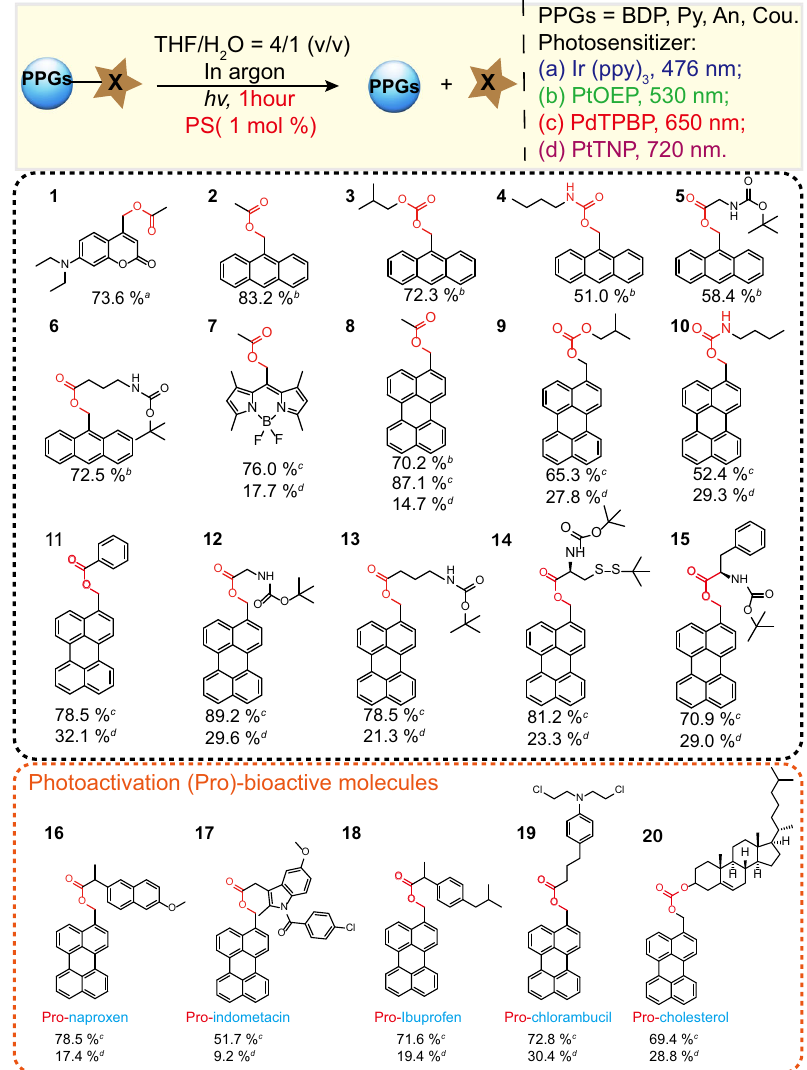
Fig. 2 Triplet – triplet annihilation-mediated photolytic reactions under diverse low power long wavelength LED irradiation. The superscripts (a – d) next to the reaction yields represent the sensitizers used and their respective operation light